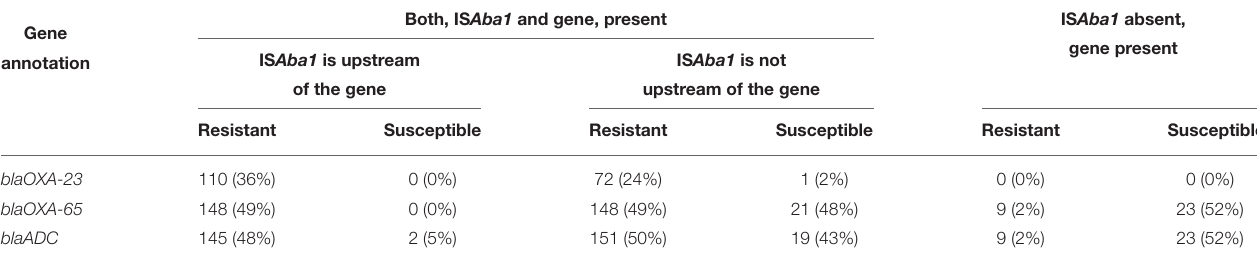
TABLE 4 | Imipenem resistance is potentiated by the presence of the IS Aba1 insertion sequence upstream of beta-lactamase genes.